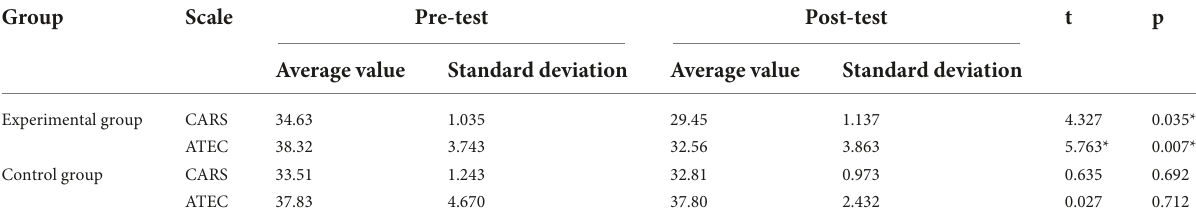
TABLE 3 Paired sample t -test results for the pre- and post-test scores of CARS and ATEC in the experimental group and the control group. Group